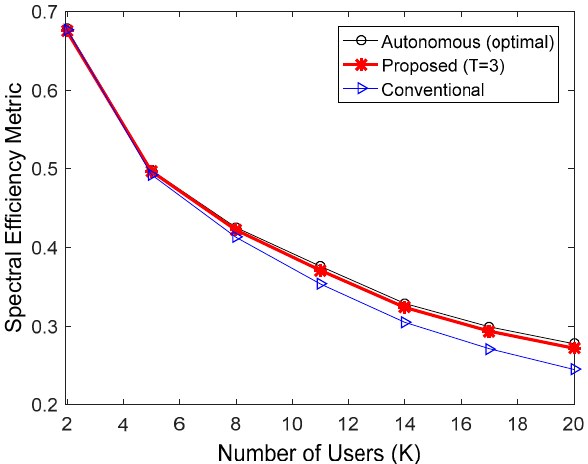
Figure 7. Comparison of spectral efficiency in the IEEE 802.16e downlink when the MCS level was fixed at 6.